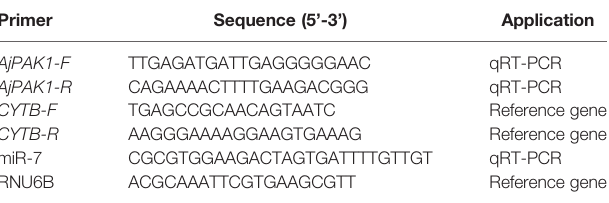
TABLE 1 | The PCR primers used in this